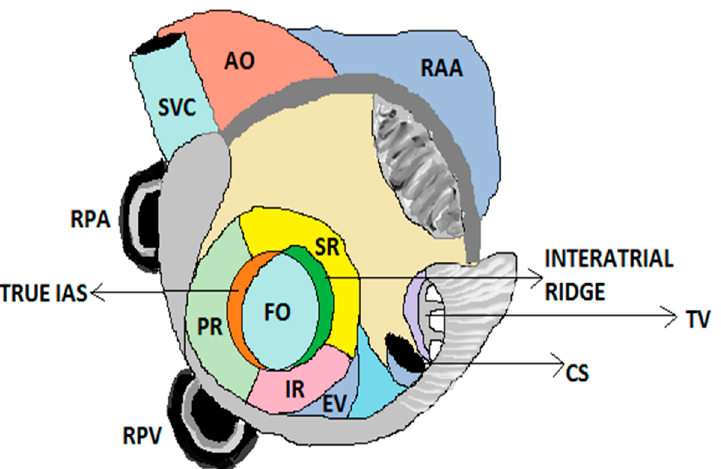
Figure 1. Schematic representation of fossa ovalis and its surrounding landmarks; AO: aortic rim; CS: coronary sinus; EV: eustachian valve; FO: fossa ovalis; IAS: interatrial septum; IR: inferior rim; PR: posterior rim; RAA: right atrial appendage; RPA: right pulmonary artery; RPV: right pulmonary vein; SR: superior rim; SVC: superior vena cava; TV: tricuspid valve.